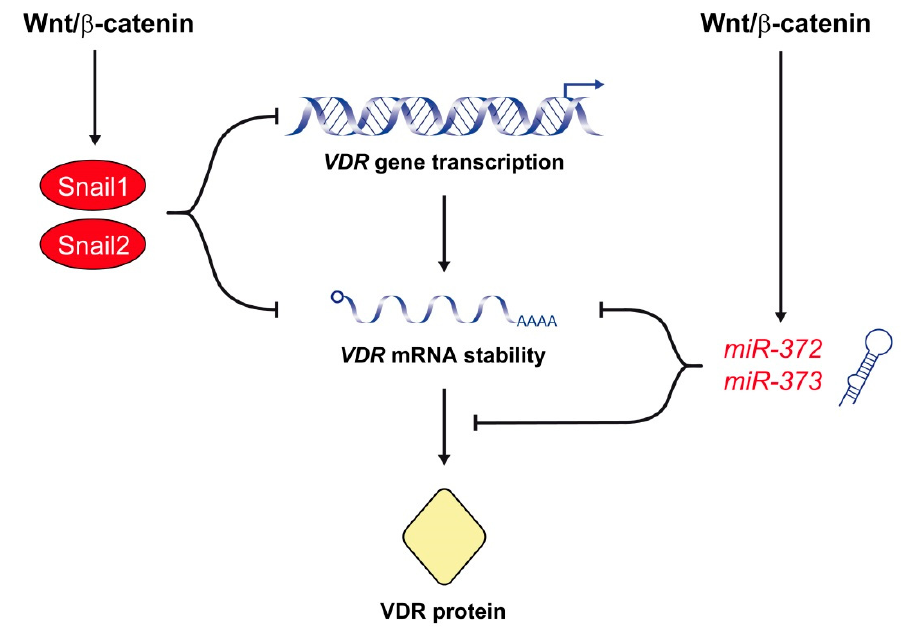
Figure 2. The Wnt/ β -catenin signaling pathway represses VDR expression. A major mechanism of this effect is the upregulation of Snail1 and Snail2, which repress VDR gene transcription and decrease VDR RNA half-life. The Wnt/ β -catenin pathway also antagonizes 1,25(OH) 2 D 3 /VDR signaling by the upregulation of miR-372 and miR-373 , which reduce the level of VDR RNA and protein.